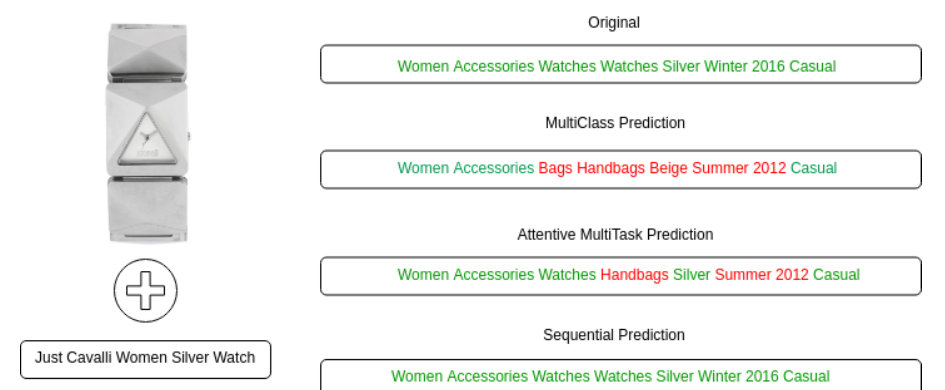
Figure 7. A sample item from the Kaggle test set with predicted attribute chains. Correctly predicted attributes are in green, the wrongly predicted attributes are in